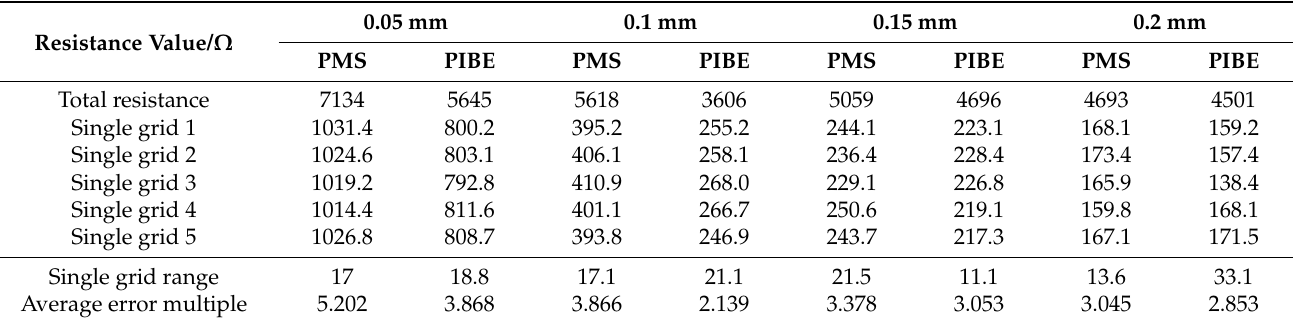
Table 3. Resistance of thin-film with different grid widths prepared by PMS and